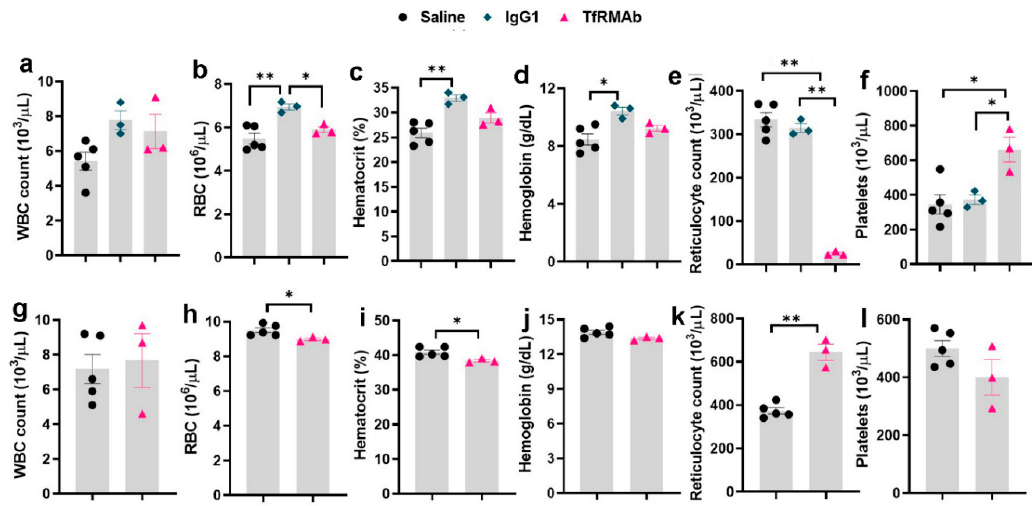
Figure 3. Complete blood count (CBC) data following acute dosing of the high-affinity bivalent TfRMAb in mice. Mice were treated with a 3 mg/kg SQ dose of TfRMAb, IgG1, or an equivalent volume of saline, and a CBC was performed either 24 h ( a – f ) or seven days ( g – l ) after the injection. No CBC data was collected for the mouse IgG1 treated mice at seven days. Data area shown as the mean ± SEM of n = 3–5 per group. * p < 0.05, ** p < 0.01.